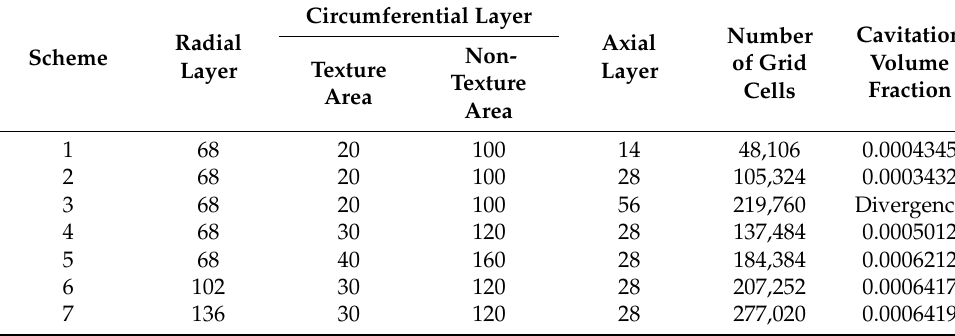
Table 3. Mesh segmentation strategy, number of grid cells, cavitation volume